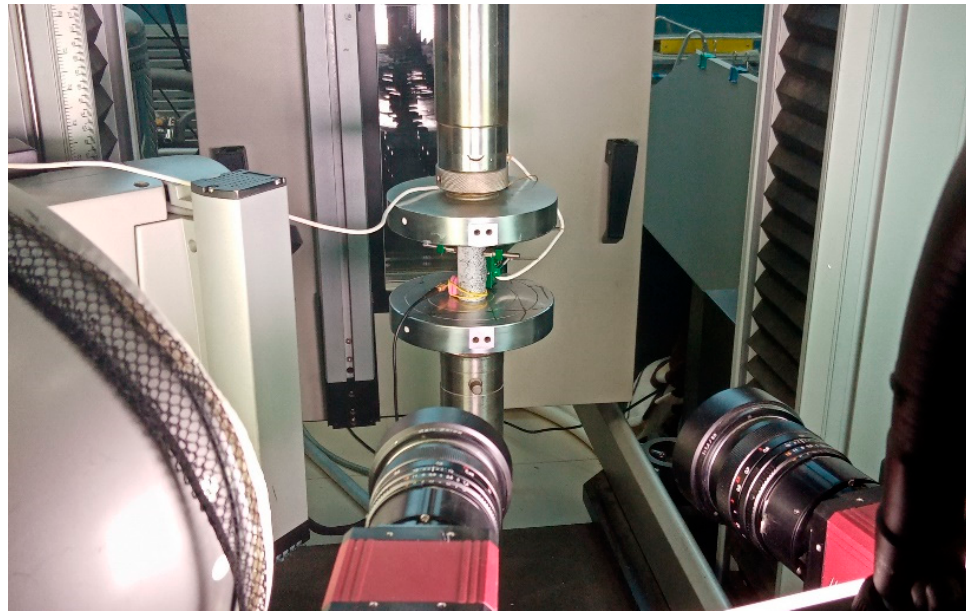
Figure 6. General view of the Vic-3D system at the moment of loading a rock sample on the Instron 5882 setup. Two cameras record the speckle structure displacement.